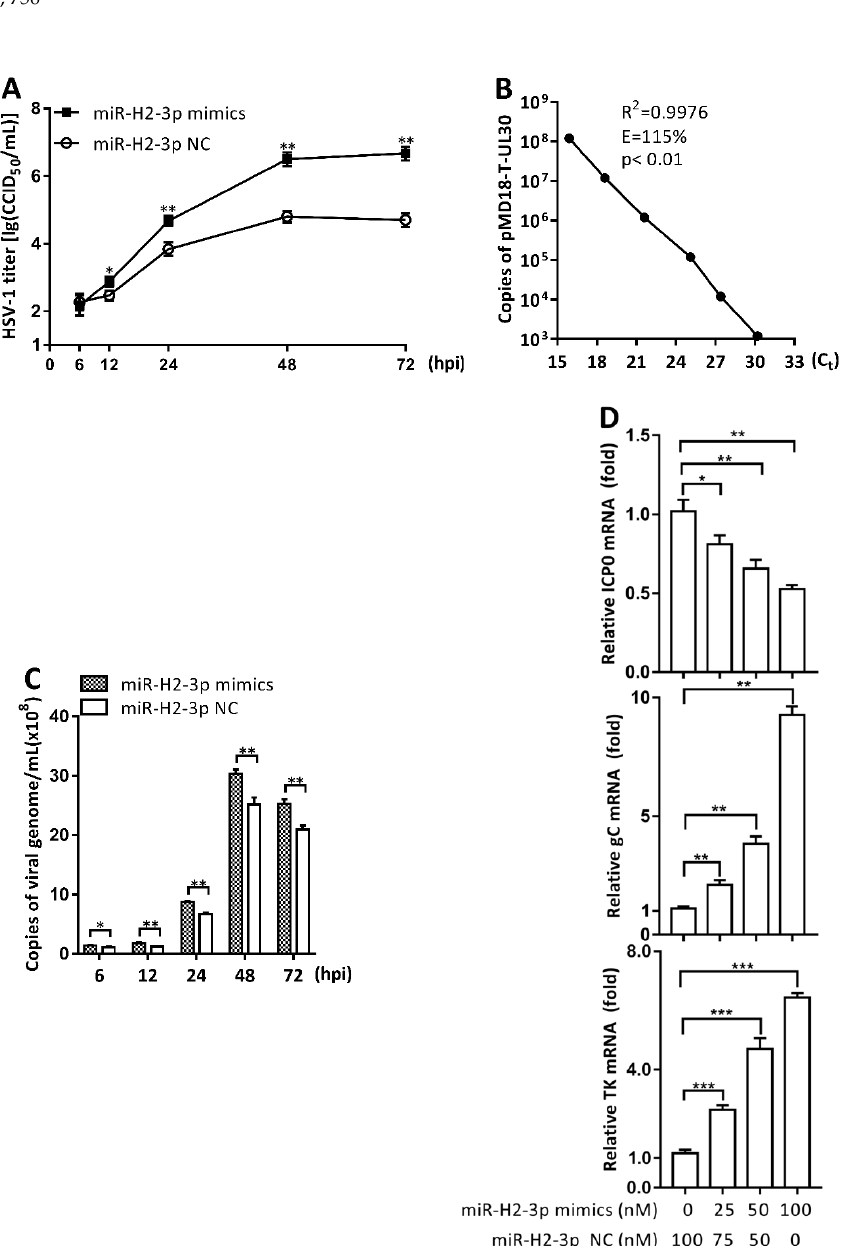
Figure 6. miR-H2-3p promoted HSV-1 replication and gene expression in THP-1 cells. ( A ) THP-1 cells were transfected with miR-H2-3p mimics or negative control (NC) (final concentration of 100 nM) for 24 h, and then infected with HSV-1 at an MOI of 1 for 6, 12, 24, 48, and 72 h, as indicated. The viral titers in the culture supernatant were determined by the CCID 50 method. ( B ) Constructed pMD18-T-UL30 plasmids were subjected to 10 times series dilution and used as a template to amplify the viral UL30 gene fragment by qPCR. Linear regression analysis with plasmid copy numbers and cycle threshold (C t ) was performed. R, Reliability; E, amplification efficiency; p, Pearson correlation coefficient. ( C ) THP-1 cells were treated as in ( A ), and the viral genome copy numbers in THP-1 cells were determined by qPCR to amplify the viral UL30 gene fragment. ( D ) THP-1 cells were co-transfected with miR-H2-3p mimics and negative control (NC) at various final concentrations for 24 h, as indicated, and then infected with HSV-1 at an MOI of 1 for 24 h. THP-1 cells were harvested, and total RNA was extracted. The expression of TK, gC, and ICP0 was determined by qRT-PCR, and the values were normalized to GAPDH. Data are the means ± SD ( n = 3) from one representative experiment. Similar results were obtained from three independent experiments. * P < 0.05; ** P < 0.01; and *** P < 0.001.